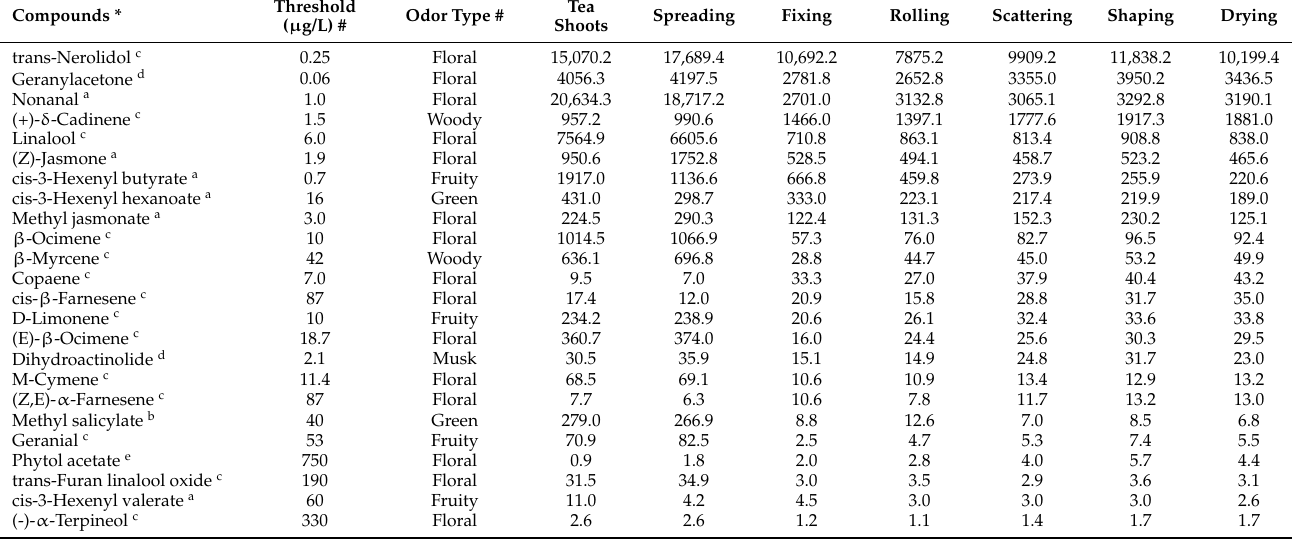
Table 2. Volatile compounds with OAVs > 1 in the processed XYMJ green tea